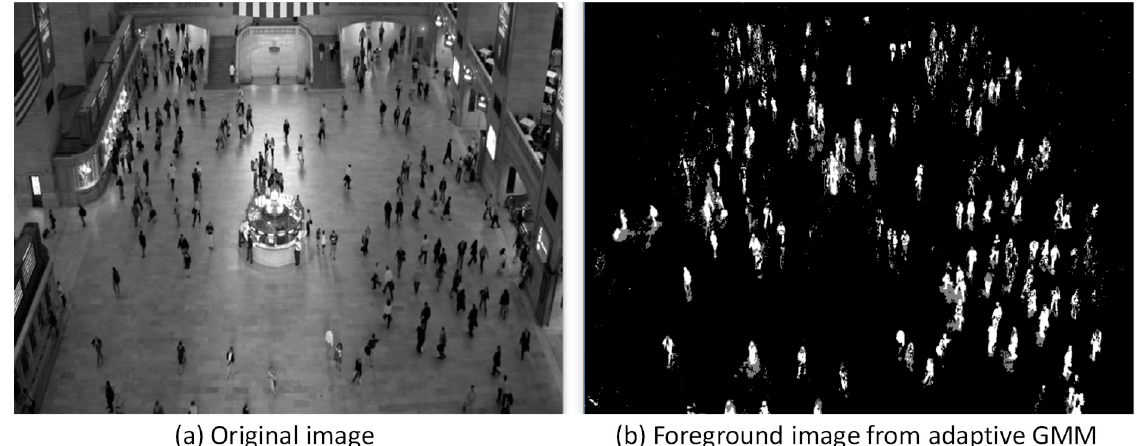
Figure 2. Images before and after processing (using adaptive GMM) [47].